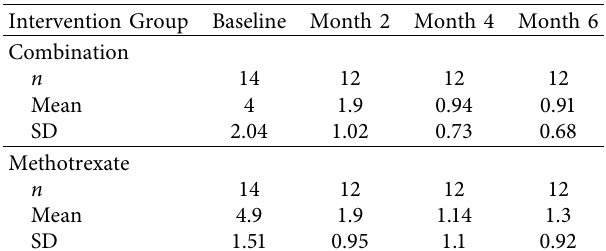
Table 3: The change in mean Lichen planopilaris activity index over time in two